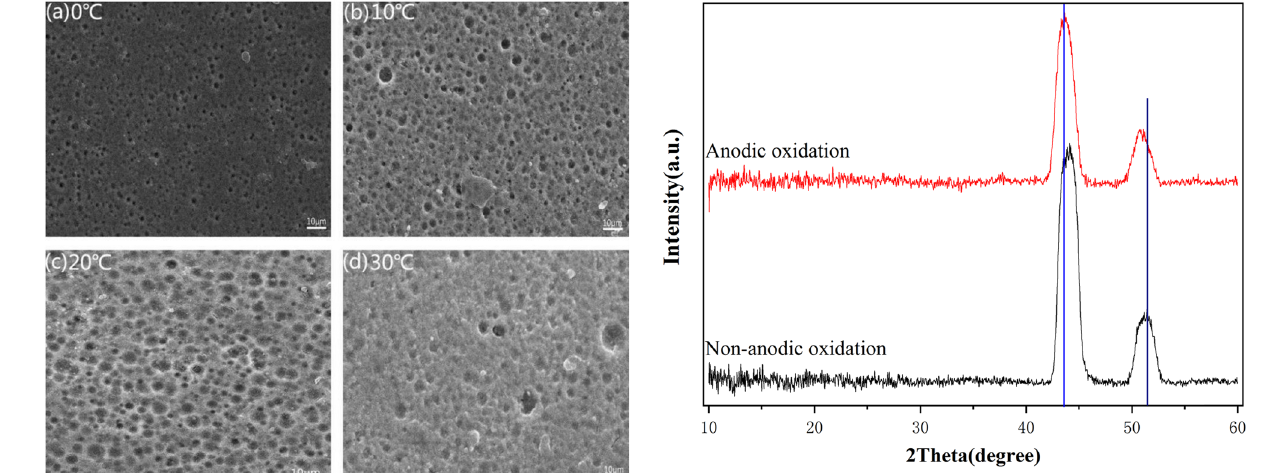
Figure 7: SEM spectra of spanner surface after anodic oxidation at di ff erent temperatures: ( a ) 0°C, ( b ) 10°C, ( c ) 20°C, and ( d ) 30°C.